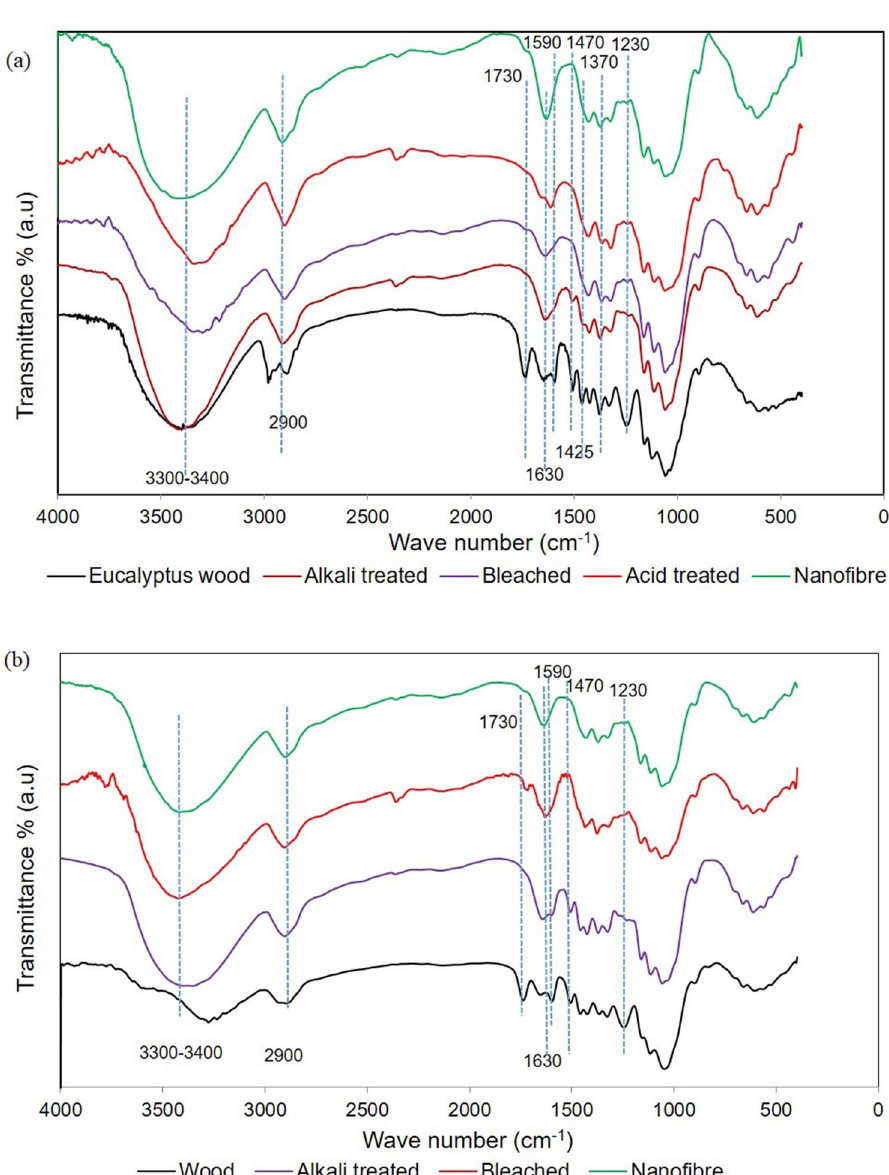
Figure 5. FT-IR spectra of untreated and treated samples of ( a ) Eucalyptus tereticornis and ( b ) Casuarina equisetifolia